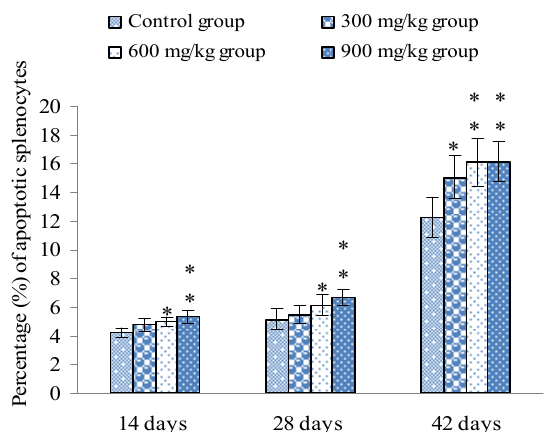
Figure 5. Percentage (%) of apoptotic splenocytes by FCM.